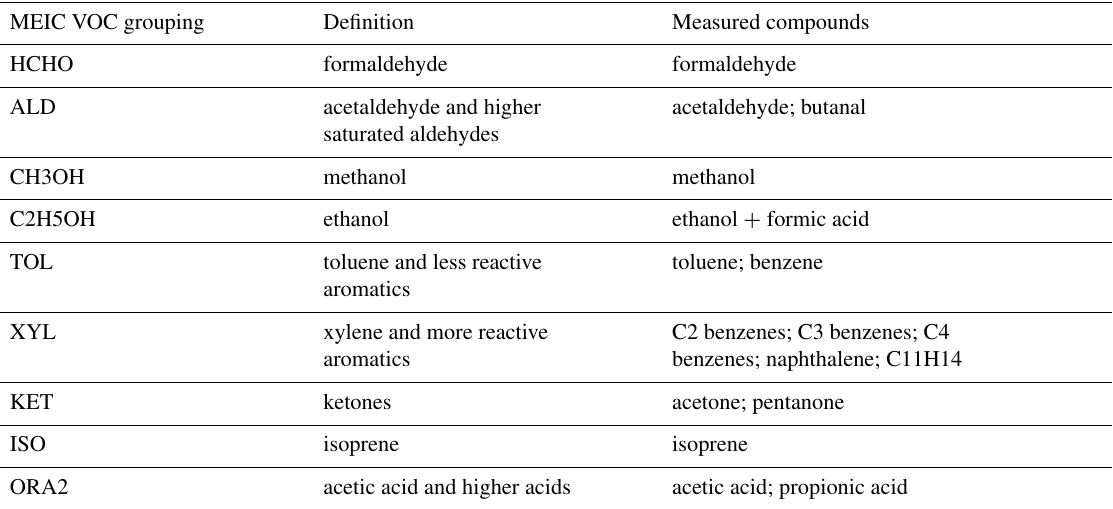
Table 3. The measured compounds used to evaluate the accuracy of the MEIC VOC groupings. MEIC VOC